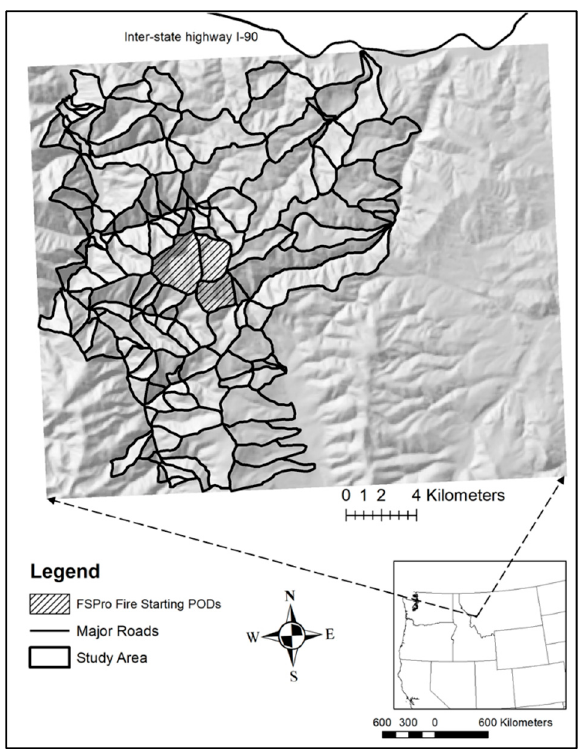
Figure 2. Case study location including pre-identified POD boundaries, the perimeter of the Sliderock Fire (used as the fire-starting location for FSPro runs), a major highway and the general location of the study site in the USA.